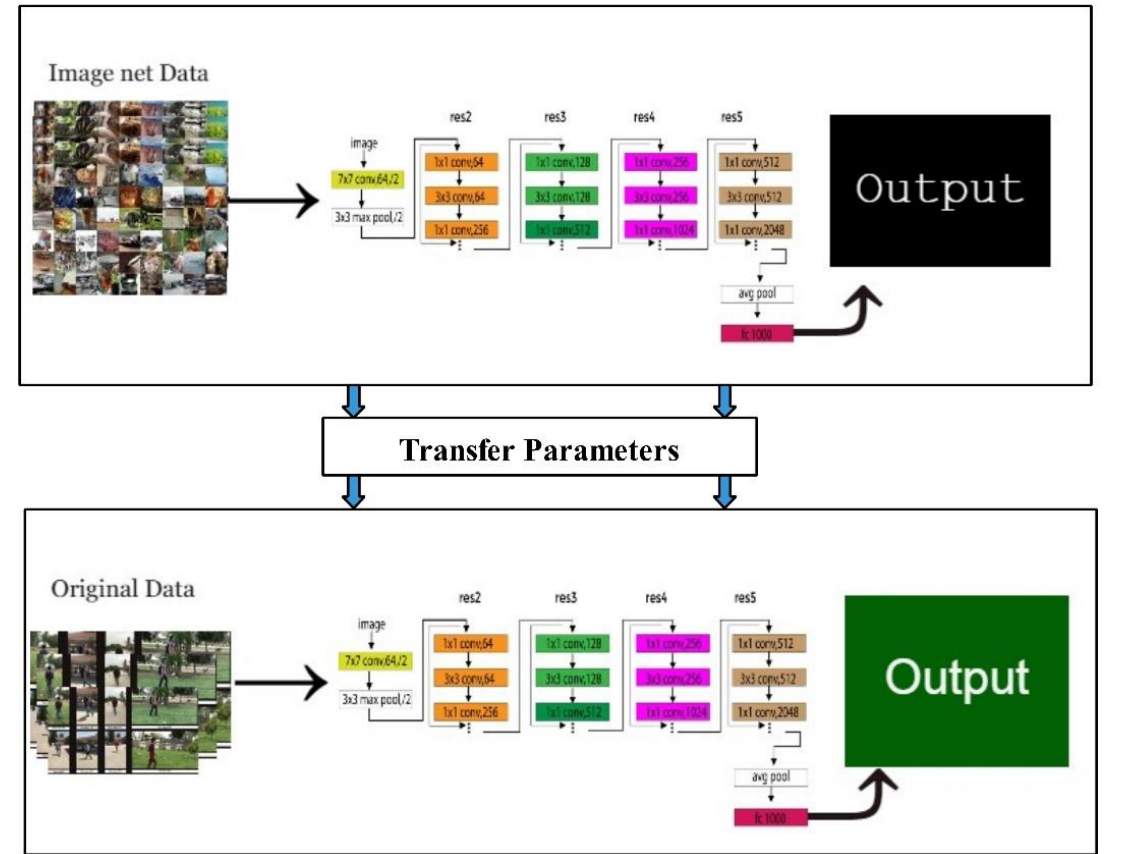
Figure 4. Transfer-learning-based model retraining on real-time captured video frames for HGR.